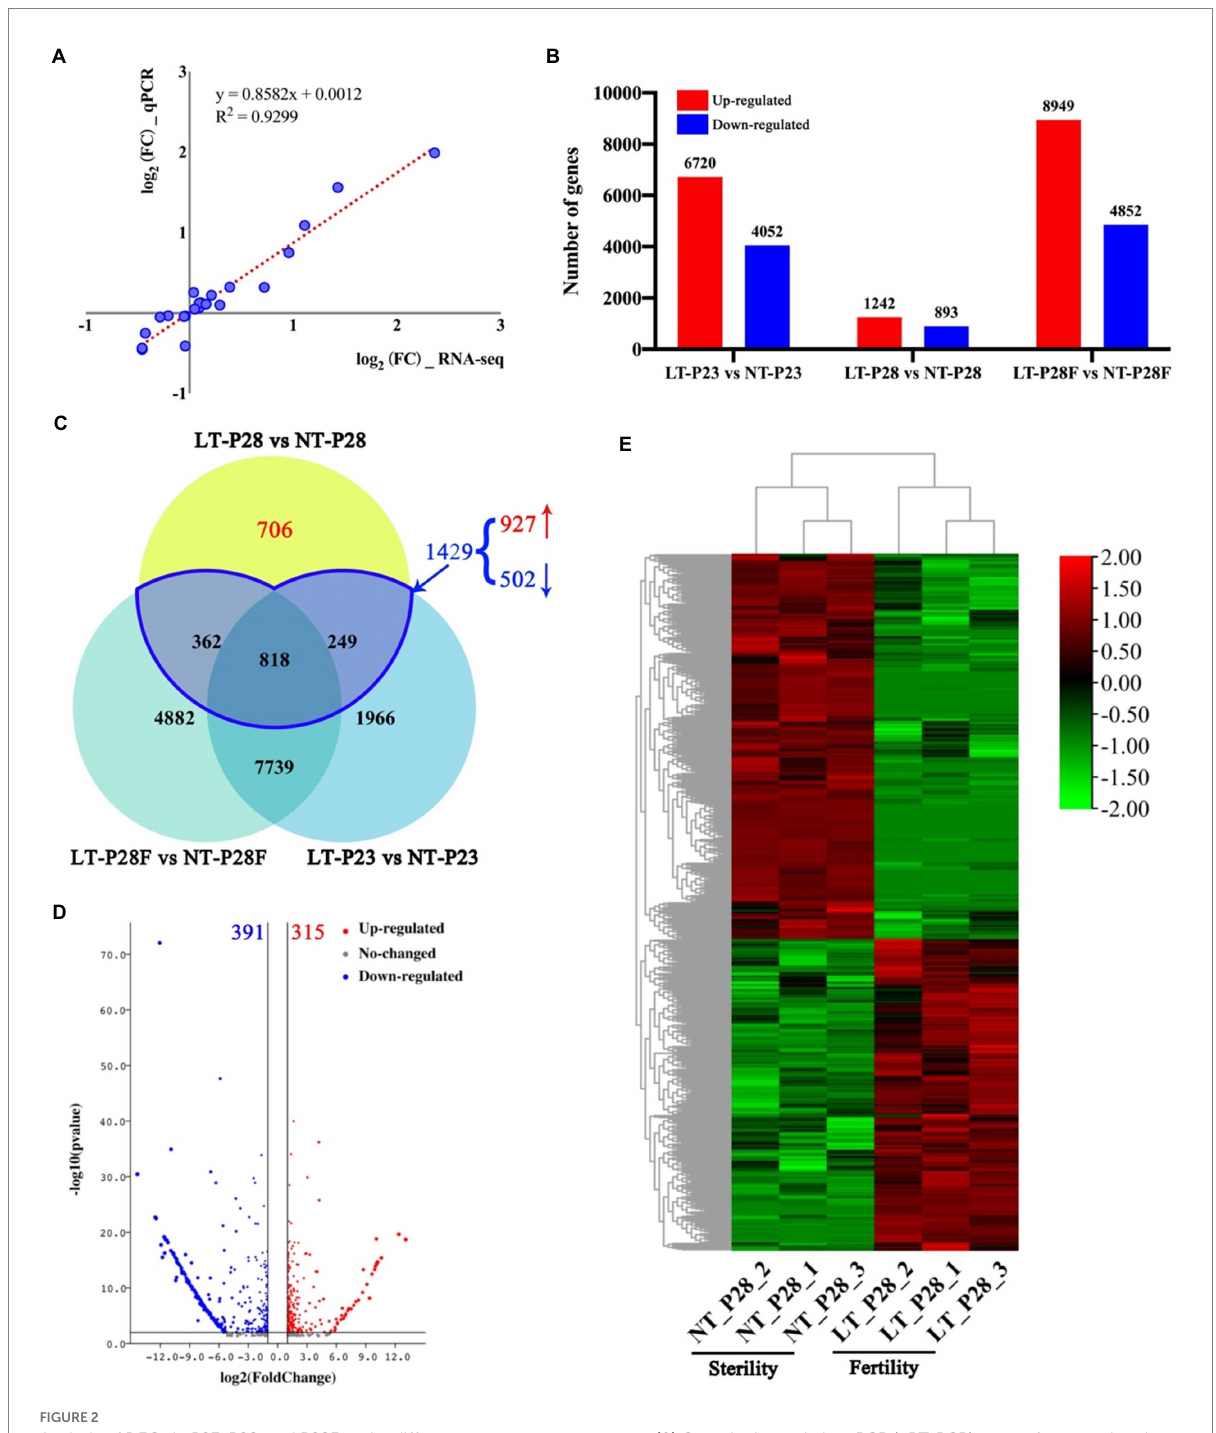
FIGURE 2 Analysis of DEGs in P23, P28, and P28F under different temperature treatments. (A) Quantitative real-time PCR (qRT-PCR) assay of sequencing data. (B) Number and up-regulation and down-regulation relationships of DEGs in P23, P28, and P28F under different temperature treatments. (C) VENN plots of DEGs in P23, P28, and P28F under different temperature treatments. (D) Up-regulation and down-regulation relationships of DEGs in response to changes in fertility. (E) Expression heat map for clustering of DEGs in response to changes in fertility. LT/NT: 23 ° C/30 ° C treatment. F/S: Fertility/Sterility plants. The red bars indicate up-regulated expressed genes and the blue bars indicate down-regulated expressed genes in B